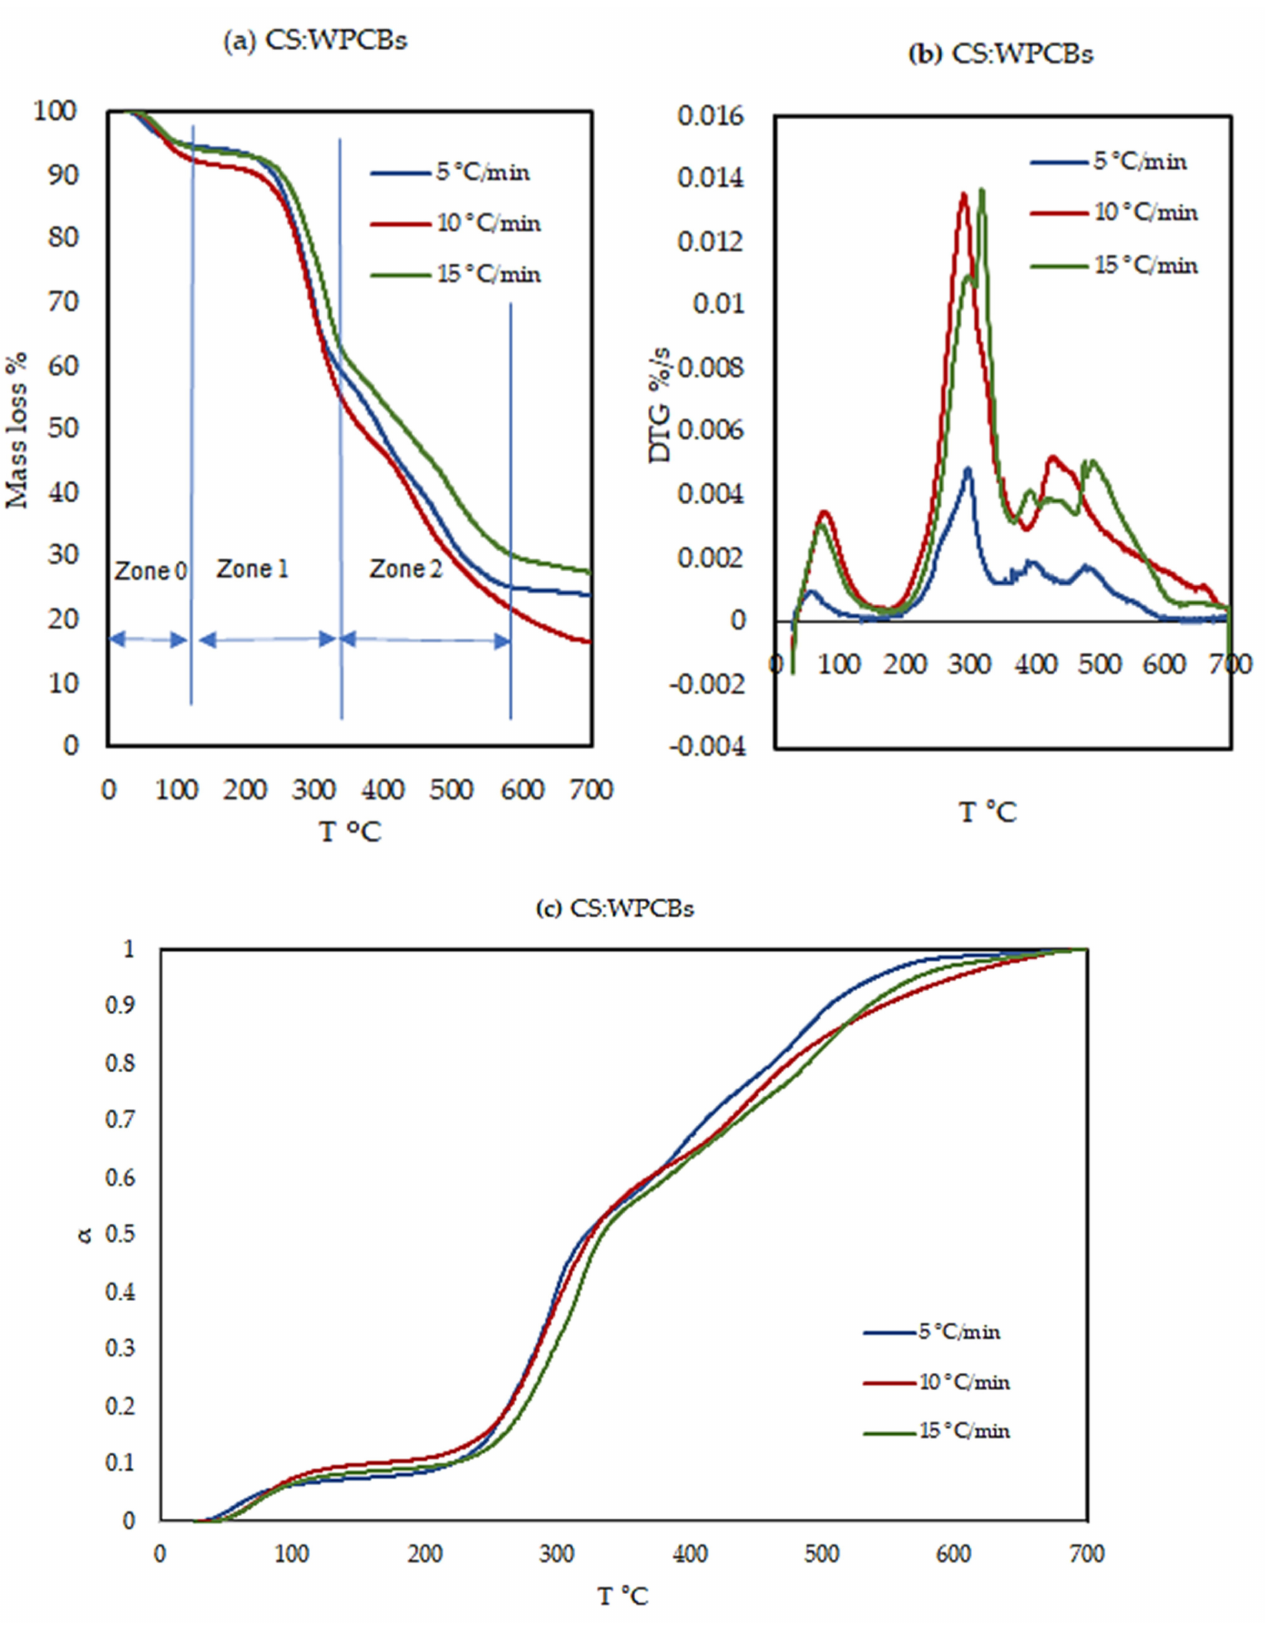
Figure 2. TG-DTG and variation of conversion as a function of temperature plots for the pyrolysis of CS:WPCBs ( a – c